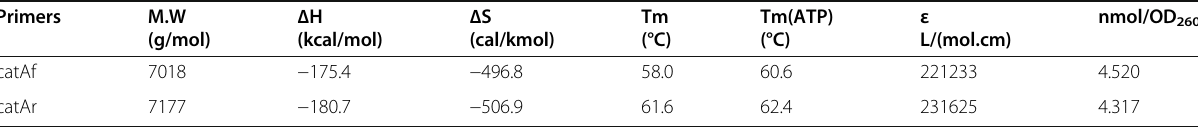
Table 4 Degenerate PCR primer properties Primers